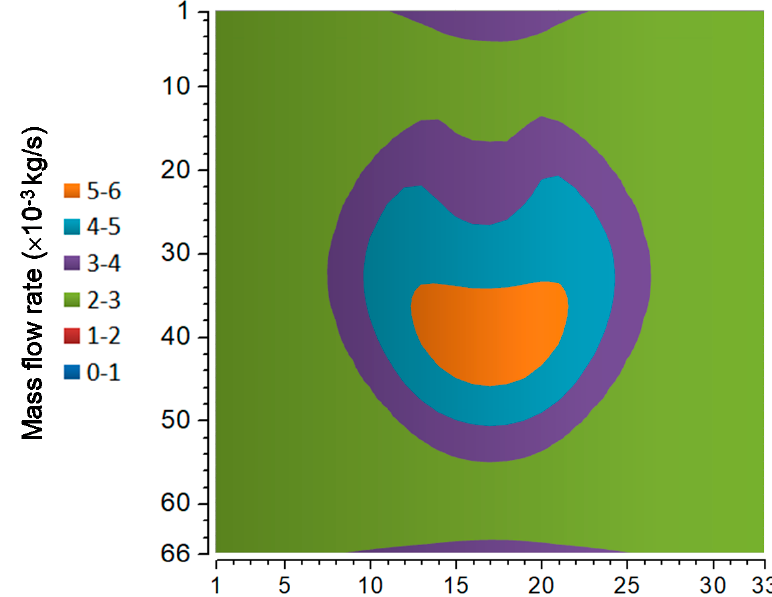
Figure 5. Distribution of the mass flow rates over the 33 × 66 channels when no perforated plate is installed.